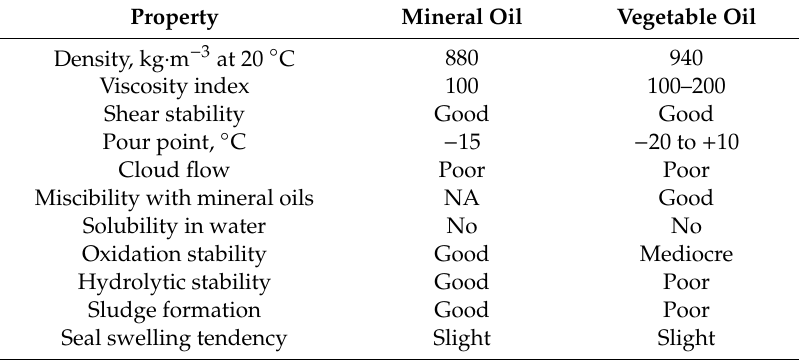
Table 1. Comparison of properties of mineral oils with vegetable